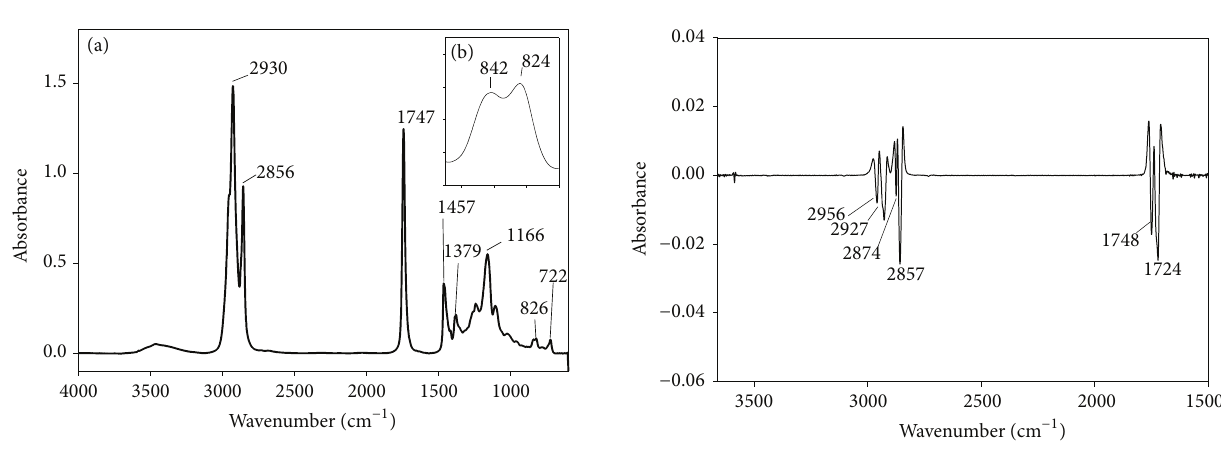
Figure 1: (a) FT-IR spectrum of the polyoxirane of milkweed oil; (b) epoxy absorption bands.